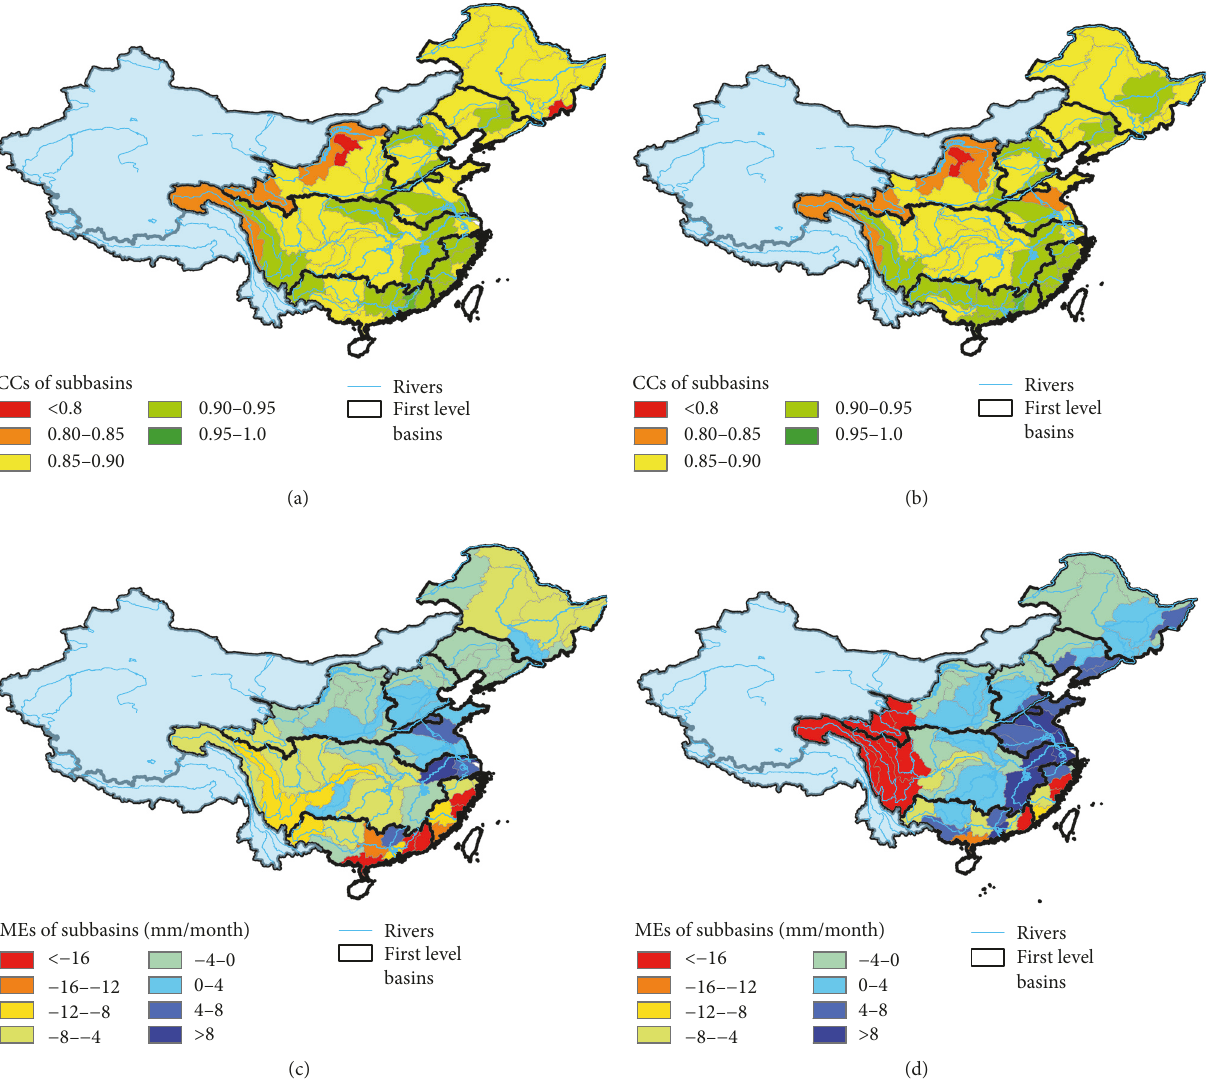
Figure 9: CC and ME distributions over 58 subbasins (included in eight main basins of eastern China) at the monthly scale from April 2014 to March 2016: CC for (a) GSMap-gauged and (b) IMERG; ME for (c) GSMap-gauged and (d)